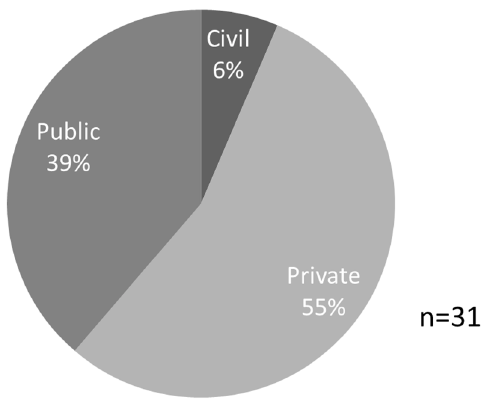
Figure 4. Representation of stakeholders from different societal sector conducted their activities in the lower part of the Kovda River catchment.